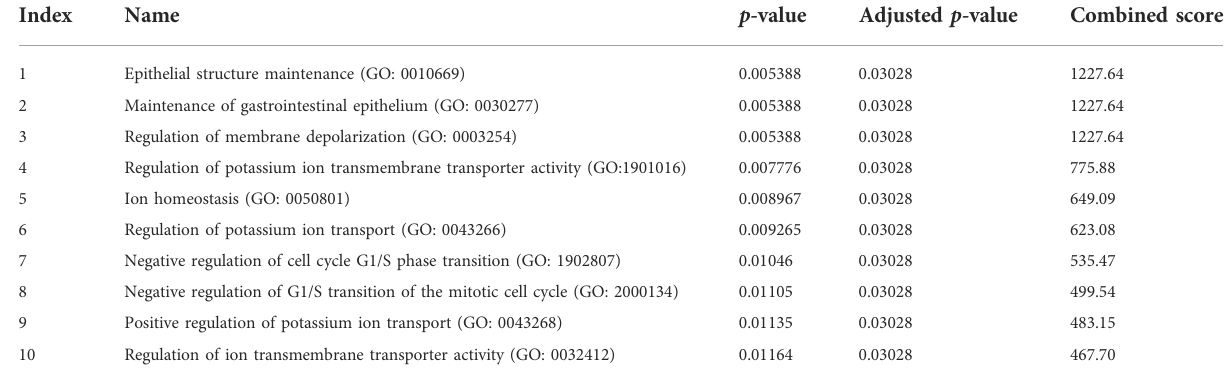
TABLE 4 Enriched biological processes of thyroid tumor downregulated gene